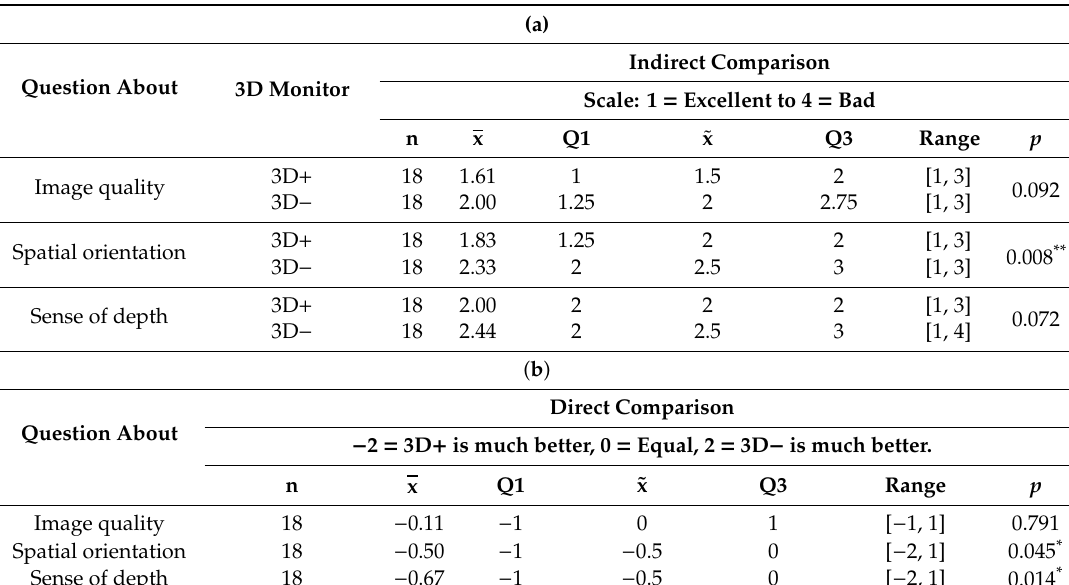
Table 3. Subjective ratings concerning optical characteristics. ( a ) Indirect comparison refers to questions regarding to each of the system, with glasses (3D + ) or without glasses (3D − ). ( b ) Direct comparison regards to the preference of participants of one system over the other